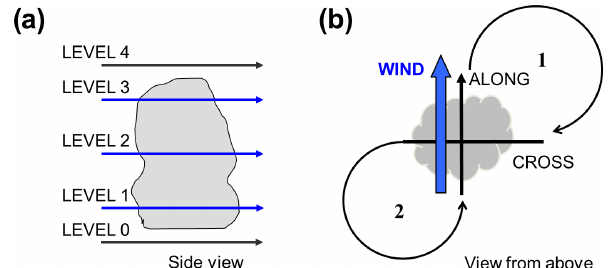
Figure 4. Definition of the chosen levels (a) and directions (b) dur- ing the measurement flights. The turns 1 and 2 in panel (b) indicate the main flight pattern resembling the number “8”, which results in repeated flight transects along and across the mean